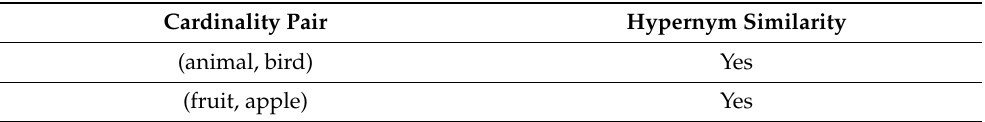
Table 9. Result of hypernym similarity of data properties between classes A and B.